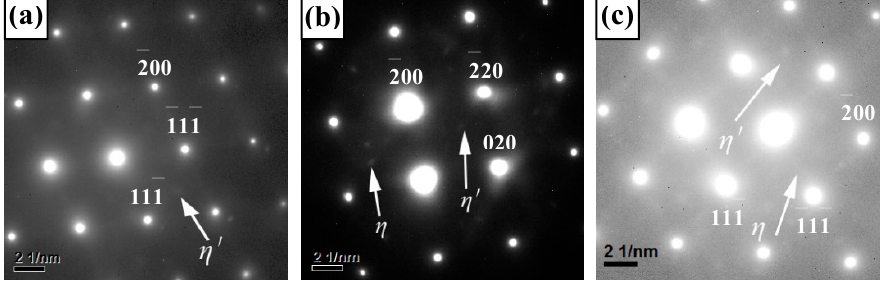
Figure 12. SAED patterns of the weld center aged at 130 °C for different times ( a ) 12 h <011>; ( b ) 24 h <001>; ( c ) 28 h <011>.